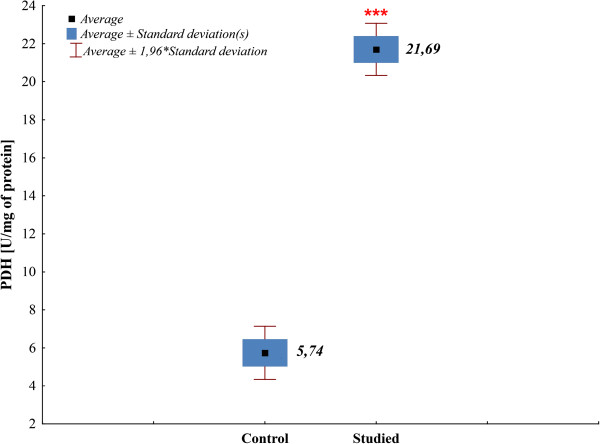
Graphical interpretation of the Cochran-Cox test, p <0.001. Comparison of average prephenate dehydrogenase enzymatic activities, PDH in the control and study group; *** - p <0.001.